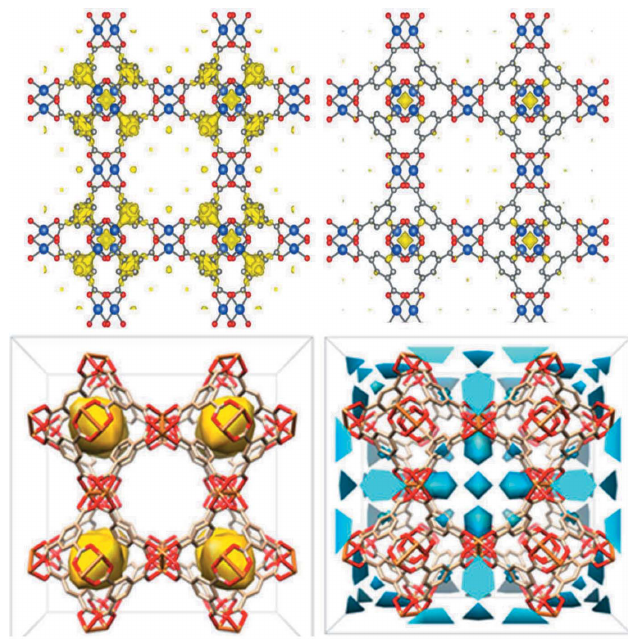
Figure 2 The nuclear density (yellow) arising from the 1.3 CD 4 molecules per Cu (top row) in Cu 3 (btc) 2 and the electron density (in yellow and blue) attributed to 1 bar of CH 4 in Cu 3 (btc) 2 obtained using TRDSE methods (bottom row) at 150 K (left) and 295 K (right). The densities are shown superimposed on one unit cell of Cu 3 (btc) 2 viewed along [1, 0, 0]. Cu 3 (btc) 2 is shown with Cu in blue (top) and orange (bottom), C in grey and O in red, and with H atoms omitted for clarity in all panels. Reprinted with permission from (top) Hulvey et al. (2015) and (bottom) Chen et al. (2015). Copyright (2015) American Chemical